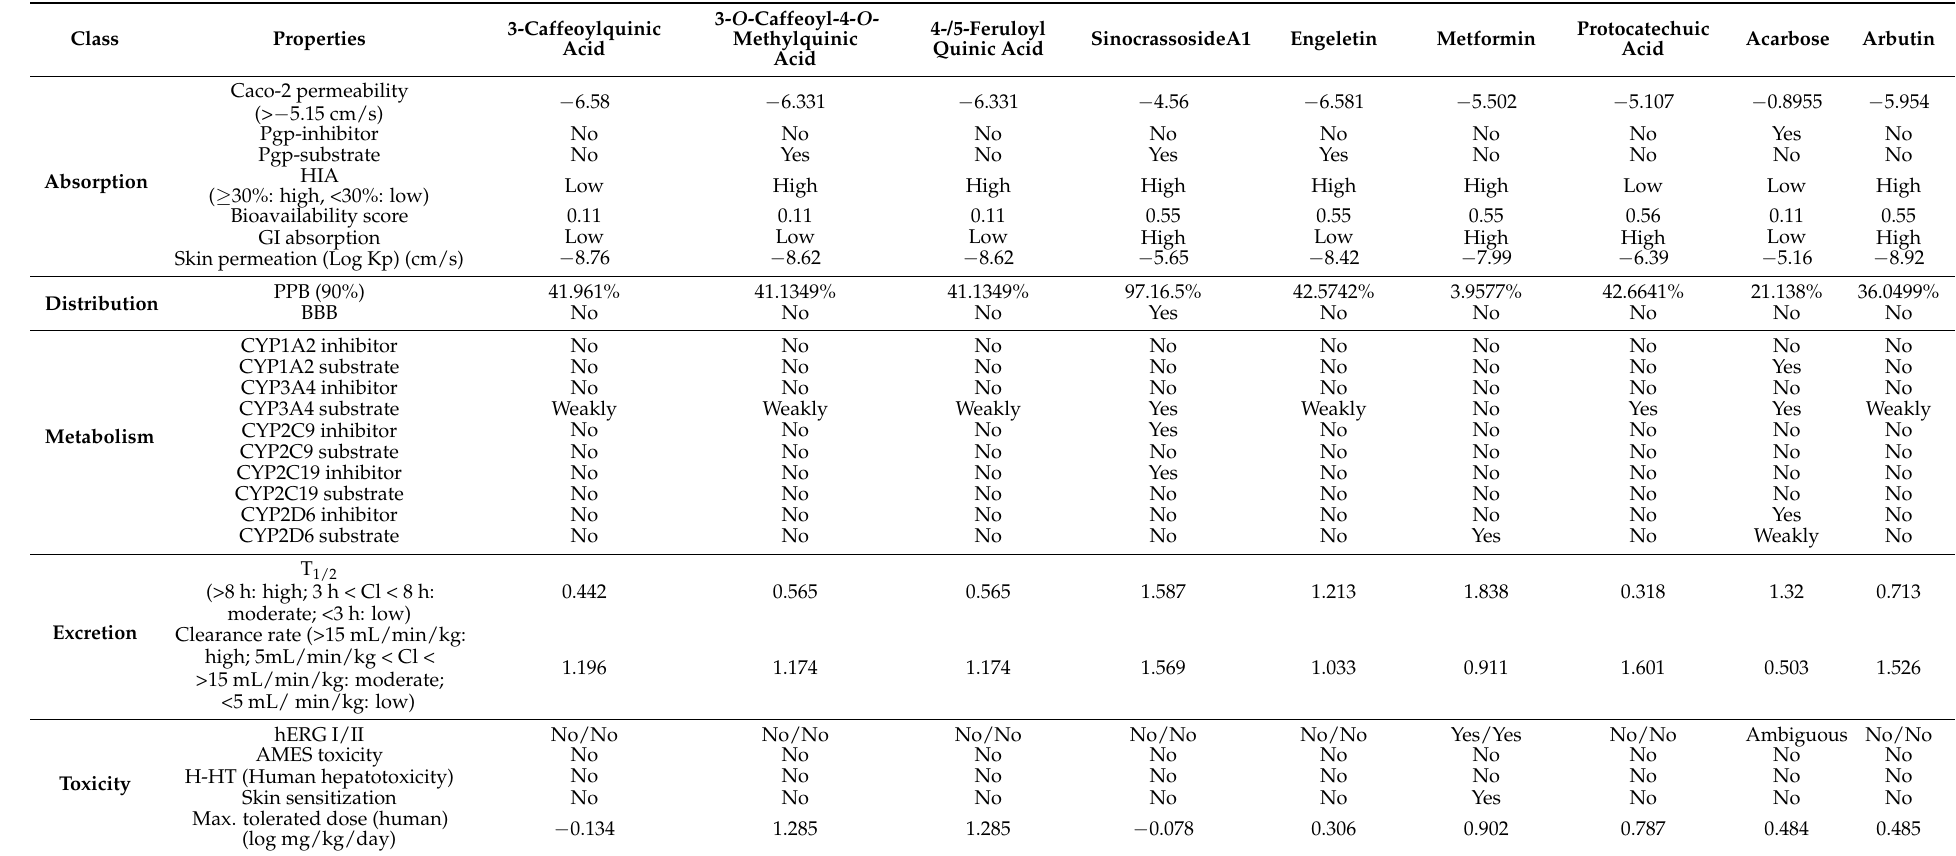
Table 3. ADMET properties of the AAHPE compounds predicted using the SwissADME online analyzer and ADMETlab web